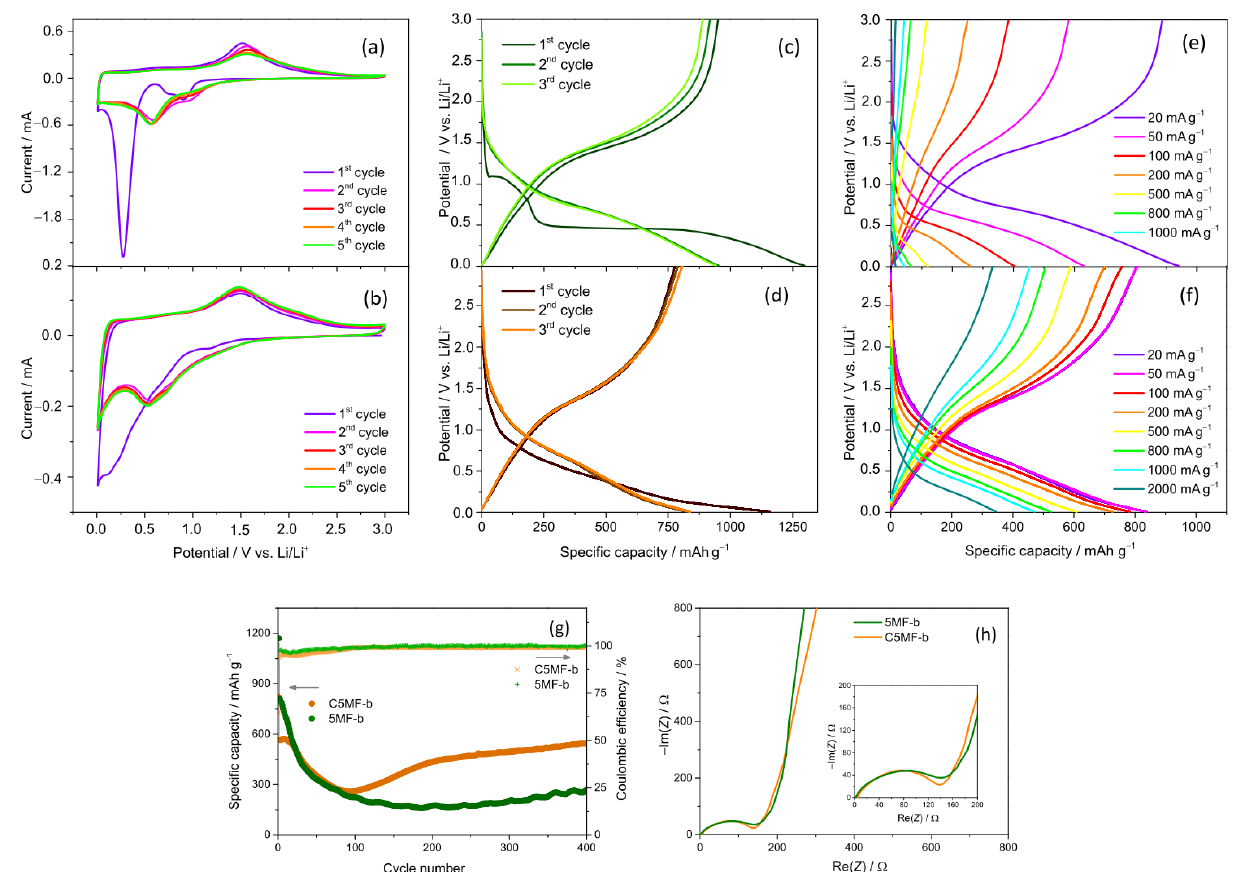
Figure 7. Electrochemical performance of samples ( a , c , e ) 5MF-b, ( b , d , f ) C5MF-b in the Li-ion half cells. ( a , b ) CV curves (scanning rate of 0.1 mV s − 1 ), ( c , d ) galvanostatic charge–discharge curves measured at 20 mA g − 1 and ( e , f ) galvanostatic charge–discharge curves measured at different current density. ( g ) Cycling stability at a current density of 500 mA g − 1 and ( h ) results of EIS measurements.